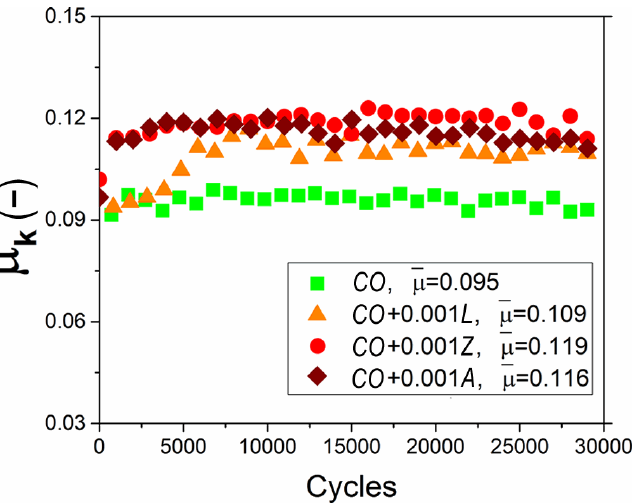
Figure 5. Effect of xanthophylls as additives in CO on the kinetic friction coefficient.